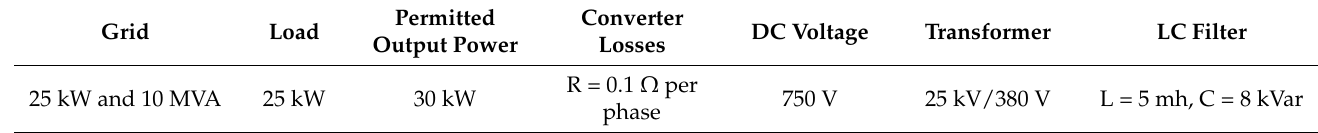
Table 1. Information of the studied system (load and